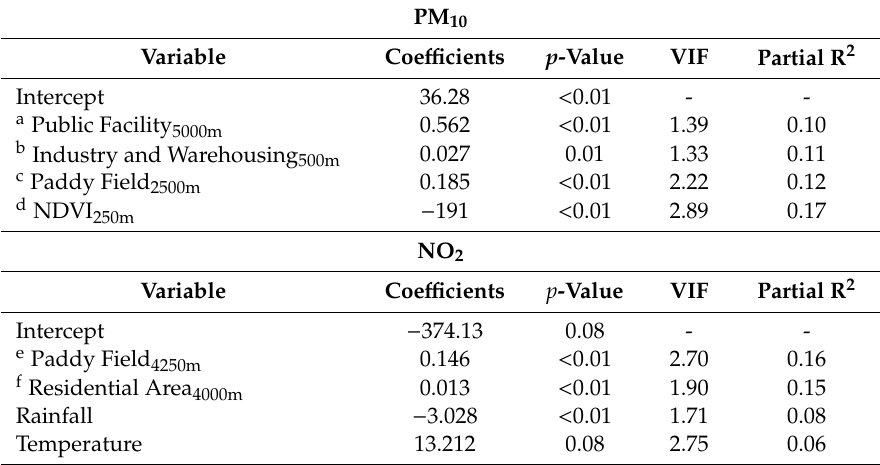
Table 1. The developed land-use regression (LUR) model for PM 10 and NO